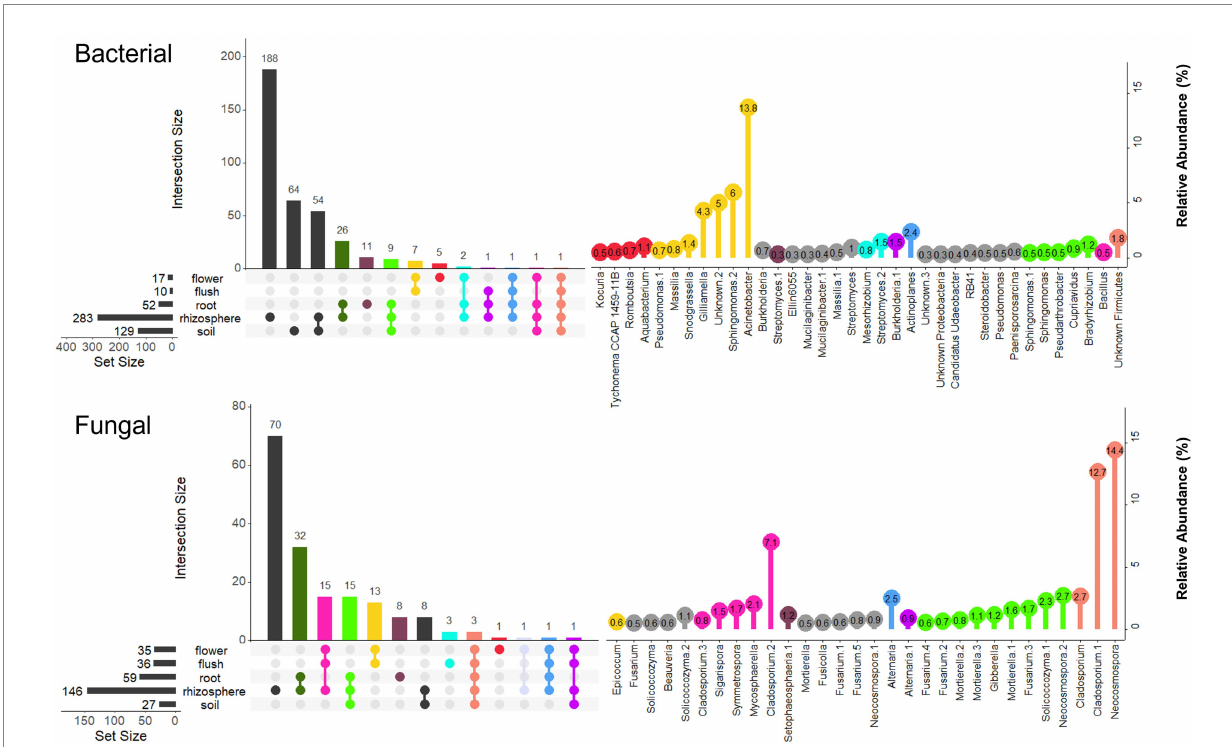
FIGURE 5 Prevalence Venn diagrams at the Amplicon Sequence Variant (ASV) level showing overlapping bacterial (top panel) and fungal (bottom panel) taxa that occur in ≥ 50% of the soil/rhizosphere/root samples and > 10% of the flush/flower samples within and across biocompartment. Only ASVs occurring at ≥ 0.5% relative abundance are displayed. Left panel represents the total number of ASVs for each biocompartment and intersection size for all biocomparment combinations. The right panel represents the ASV relative abundance (%) and color refers to the left panel and the biocompartment(s) where the ASVs were